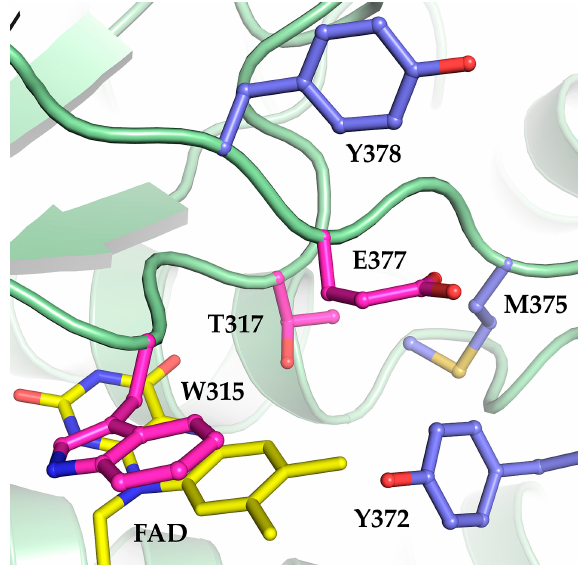
Figure 1. Structure model of Mcd from Rhodobacter sphaeroides based on the human short-chain acyl-CoA dehydrogenase (PDB ID: 2VIG). The engineered oxidase (Mco, green backbone) comprises three mutations: W315F, T317G and E377N (pink residues) around the FAD cofactor (yellow). We targeted three additional residues (Y372, M375, and Y378; blue residues) for site-directed mutagenesis with the aim to further increase oxidase activity by making the active site more solvent accessible.